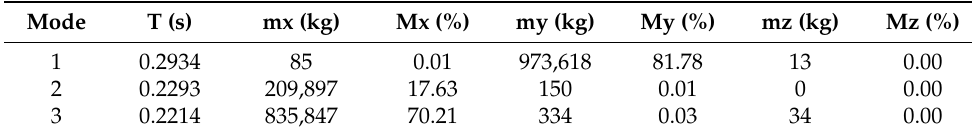
Figure 16. Capacity curve (black) and its bilinear idealization (orange) for x -direction.